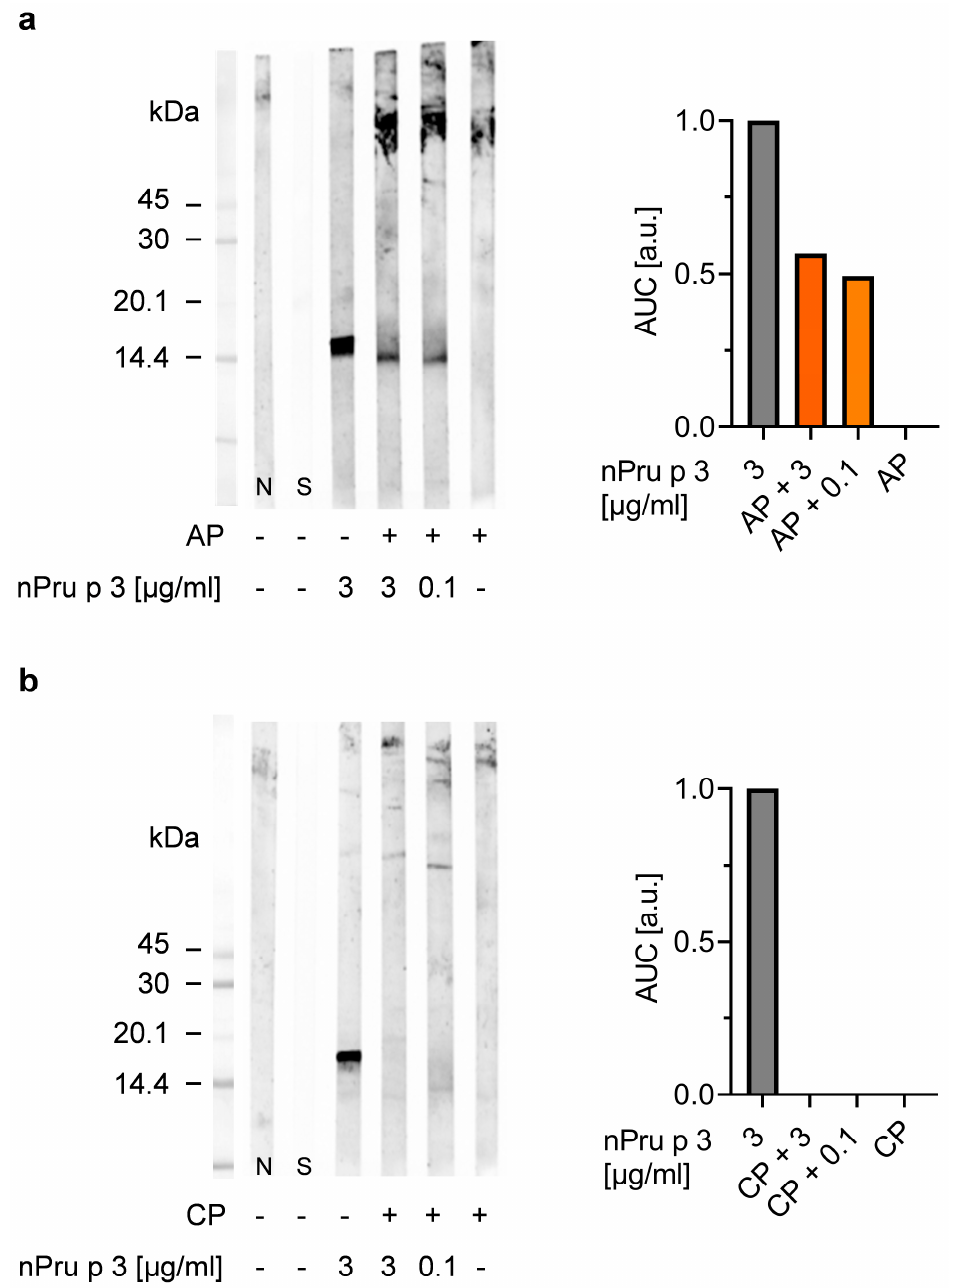
Figure 5. Detection of nPru p 3 spiked in 10% Fruktozym-treated apple-derived pectin (AP) ( a ), or citrus-derived pectin (CP) ( b ) via immunoblotting. The spiking concentrations represent the nsLTP thresholds eliciting anaphylactic (3 µg/mL) or oral symptoms (0.1 µg/mL). Detected bands were analyzed semi-quantitatively as area under the curve (AUC) normalized to blank.